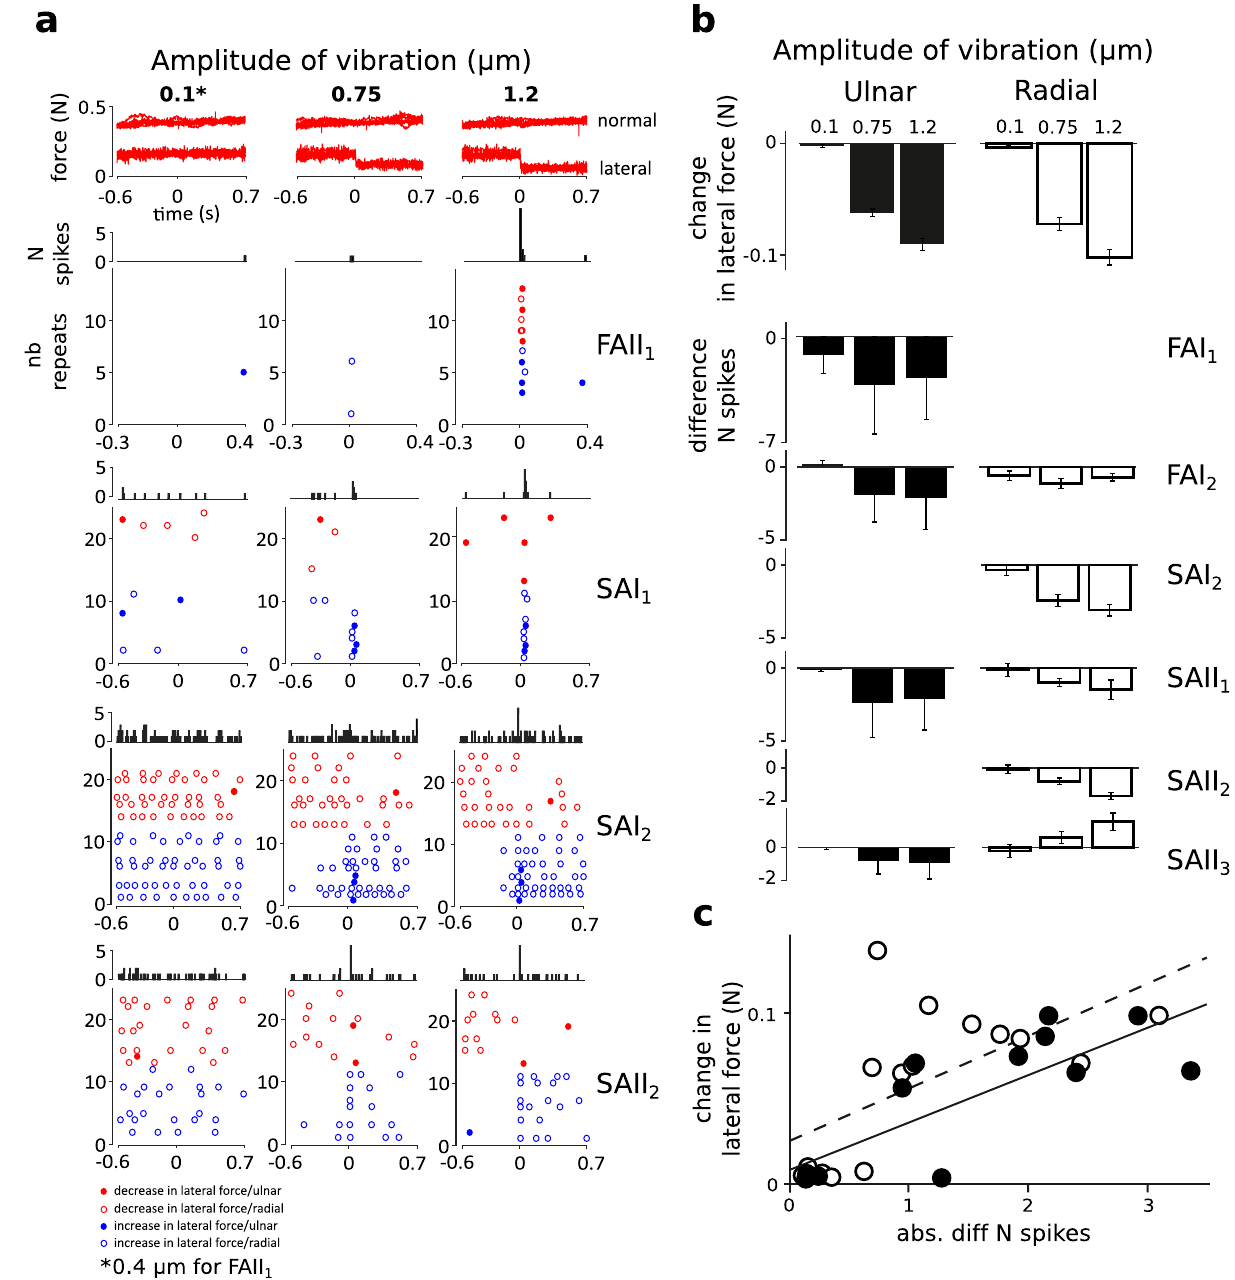
Figure 2. Step in friction level. ( a ) Top panel, superimposed recordings of normal and lateral force for the three amplitudes of ultrasonic vibration tested (0.1 μm, 0.75 μm and 1.2 μm). The action of the device from t = 0 effectively reduced the lateral force on the side of the modulation for the two larger amplitudes. Panels below show PSTHs (10 ms bins) and raster plots of unit firing for four representative units (FAII 1 , SAI 1 , SAI 2 and SAII 2 ). Colours illustrate the friction condition, i.e. decrease in friction level over time (red) or increase (blue). Dot filling represents the sliding direction, with filled dots for the ulnar direction and unfilled dots for the radial direction. Note that the sequences of repeats have been grouped per friction condition in the plots to improve their readability; hence they do not reflect the randomization sequences. For each unit, all repeats are shown. Repeats are left empty when no spikes were elicited, which highlights the scarcity of the responses to the stimulation. FAII 1 and SAI 1 showed time-locked responses to the moment of change in friction. SAI 2 and SAII 2 showed the same effect, revealed by the PSTH, as well as a reduction in the number of spikes with friction reduction (stable phase of the stimulation). ( b ) Top panel, average change lateral force (i.e. including the conditions of increase or decrease in friction) measured separately for the two sliding directions, and for the three amplitudes of ultrasonic vibration tested for the 8 units. Panels below show the average difference in number of spikes (between the baseline vs. stimulation phase) for each unit. The error bars represent the standard error of the mean. ( c ) Correlations between the change in lateral force vs. the change in the number of spikes are shown at group level, in the ulnar (black dots, black regression line); and radial directions (unfilled dots, dashed regression